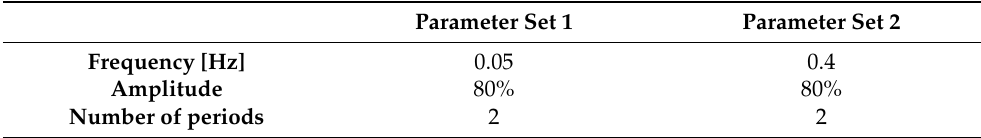
Table 5. Parameter combinations used for the inspection of each sample using lock-in thermography. The number of periods is kept constant at a value of two, and the amplitude is kept constant at 80% of the maximum